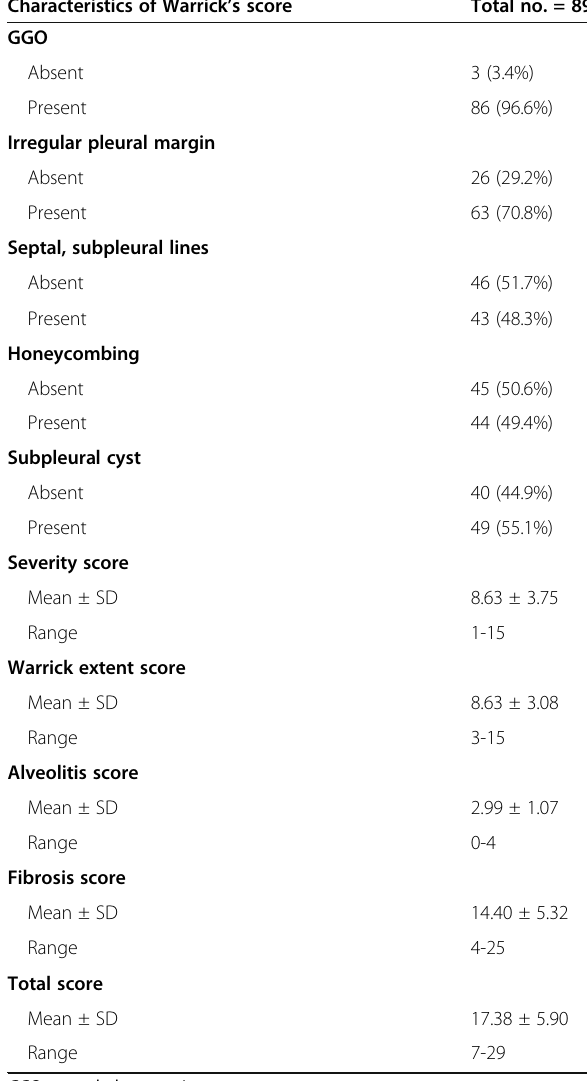
Table 4 Warrick ’ s score and its characteristics among the studied population